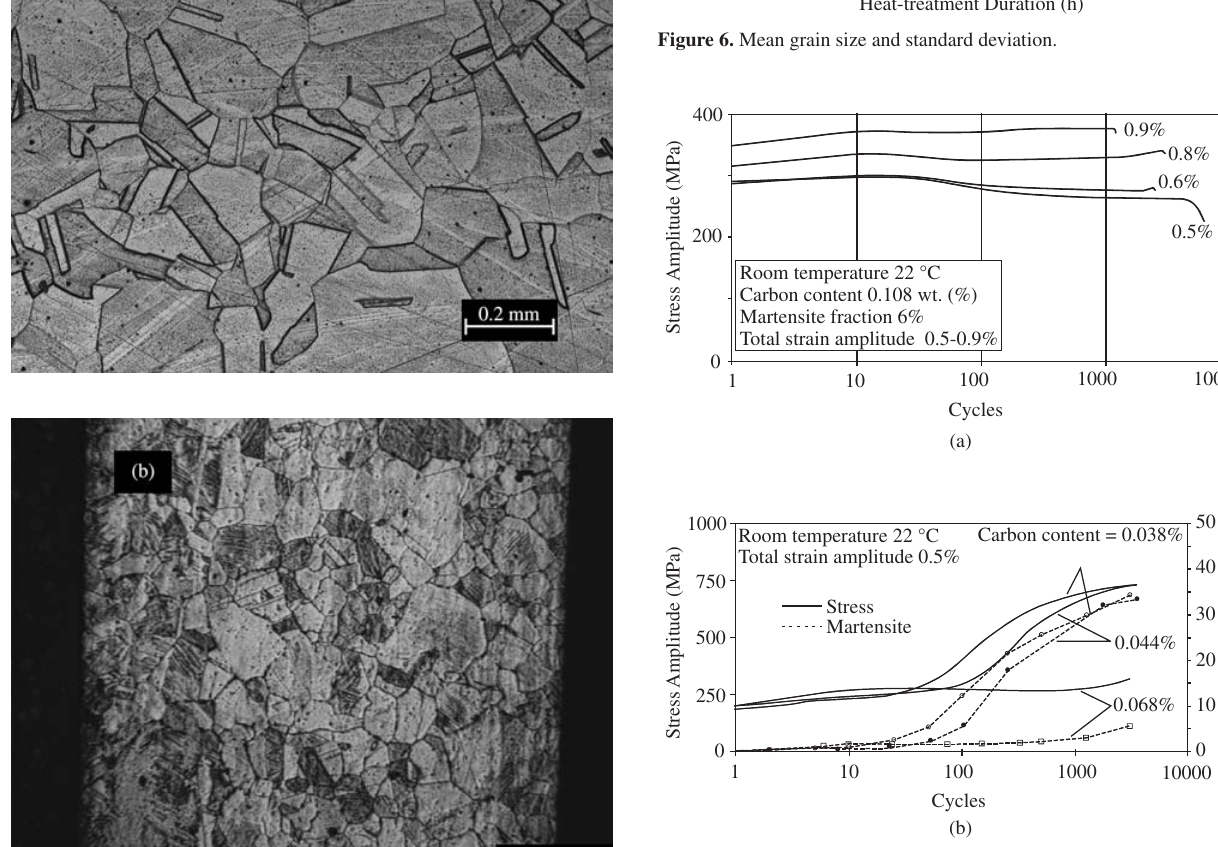
Figure 7. a) Influence of total strain amplitude on test specimens in the as- received condition; and b) Influence of carbon content at a constant strain amplitude.